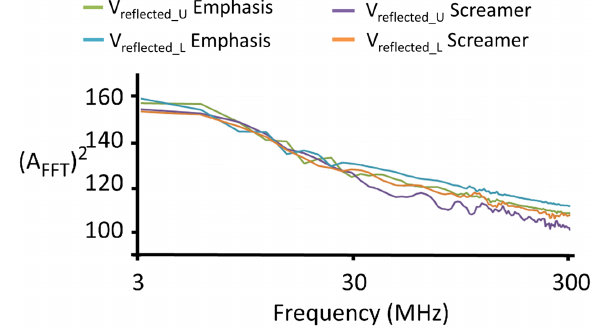
FIG. 14. Fast Fourier transform spectra for the backward going wave at the beginning of OTL2 for both upper (U) and lower (L) levels from Emphasis and Screamer simulations of the CSMITL.